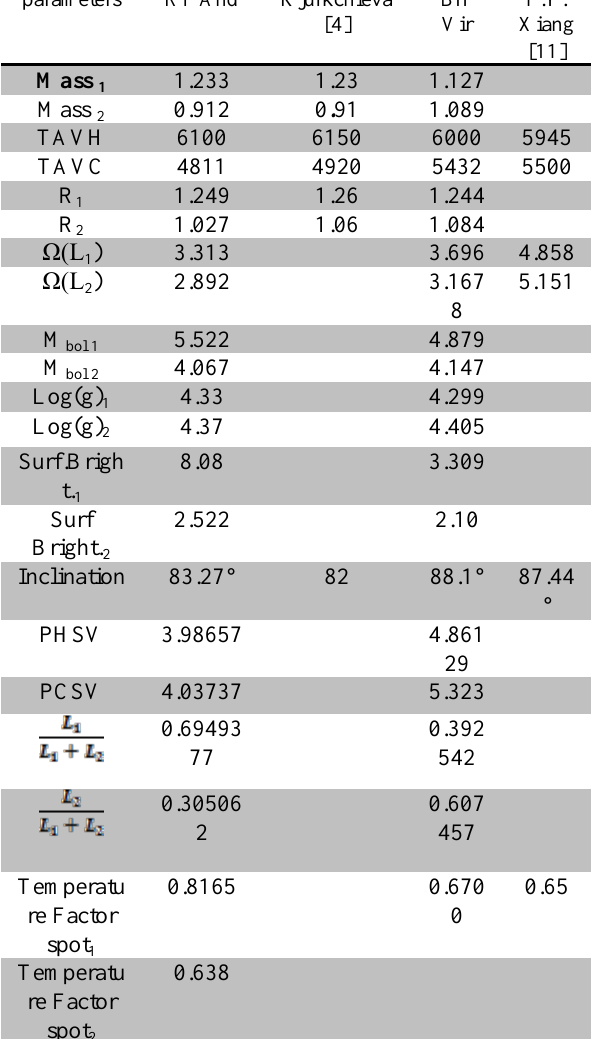
Table 2: The physical parameters of RT And and BH Vir Using PHOEBE